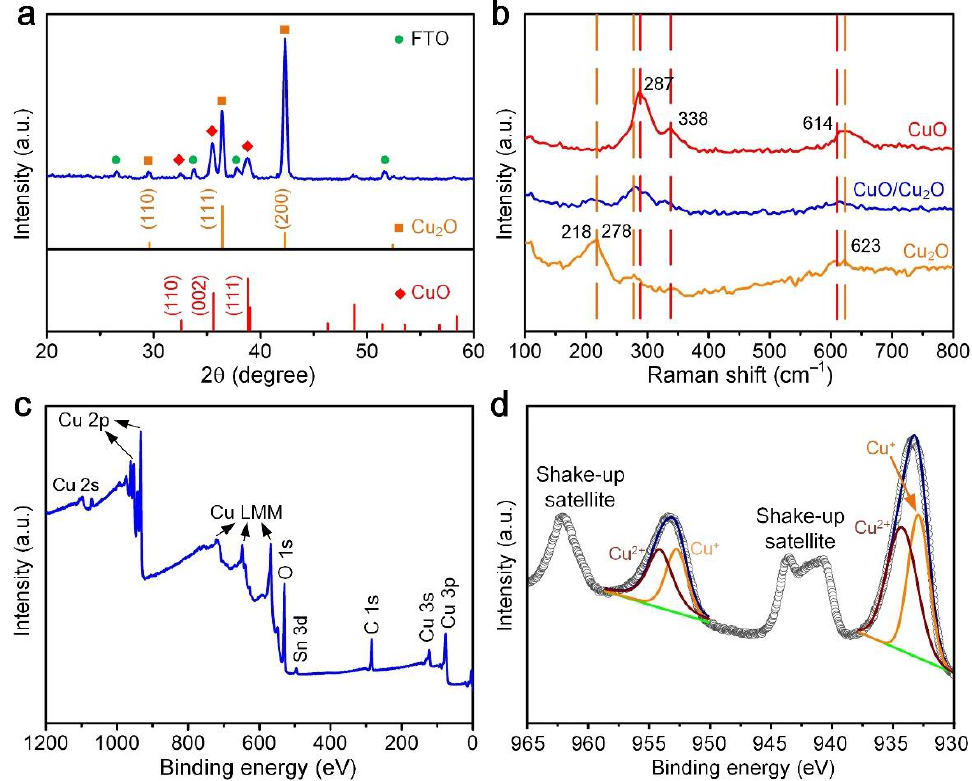
Figure 4. ( a ) XRD pattern of the CuO/Cu 2 O thin film. The diffraction peaks can be indexed with Cu 2 O (JCPDS file No. 99-0041) and CuO (JCPDS file No. 72-0269); ( b ) Raman spectra of Cu 2 O, CuO/Cu 2 O, and CuO thin films; ( c ) the full XPS survey spectrum of the CuO/Cu 2 O thin film; ( d ) high-resolution XPS spectrum of Cu 2p of the CuO/Cu 2 O thin film. The dotted curve is the experimental data, while solid curves are after the curve-fitting procedure.